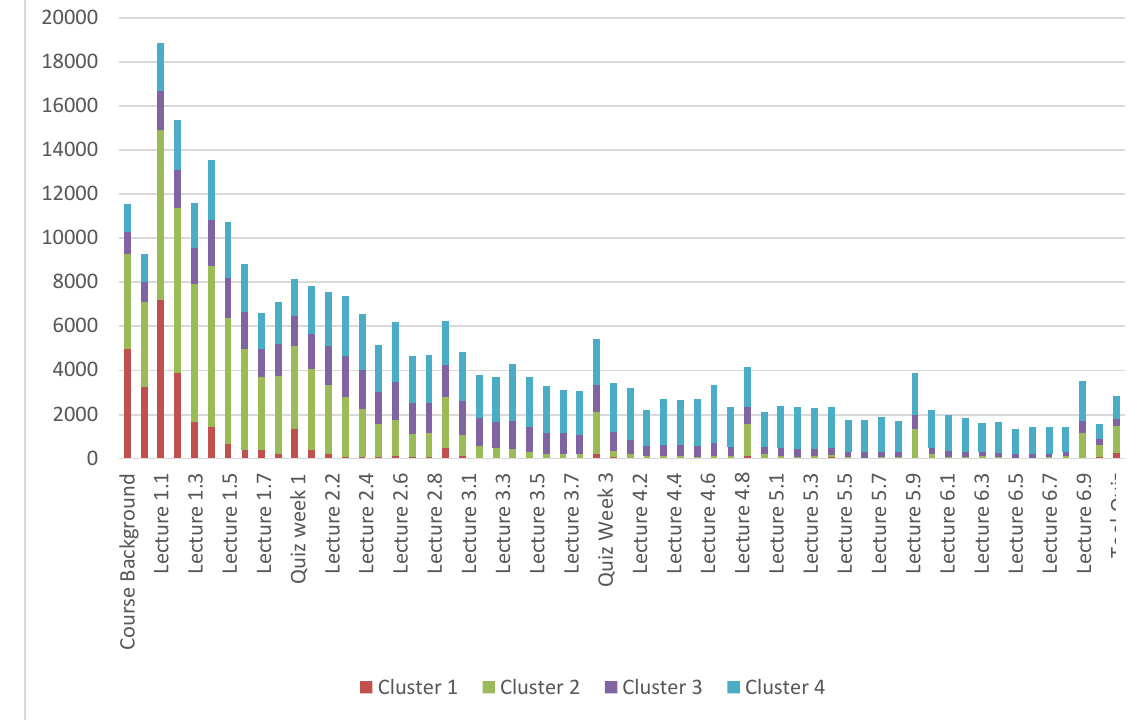
Figure 6. Activity frequency counts split per cluster. Cluster Analysis Using Dotted